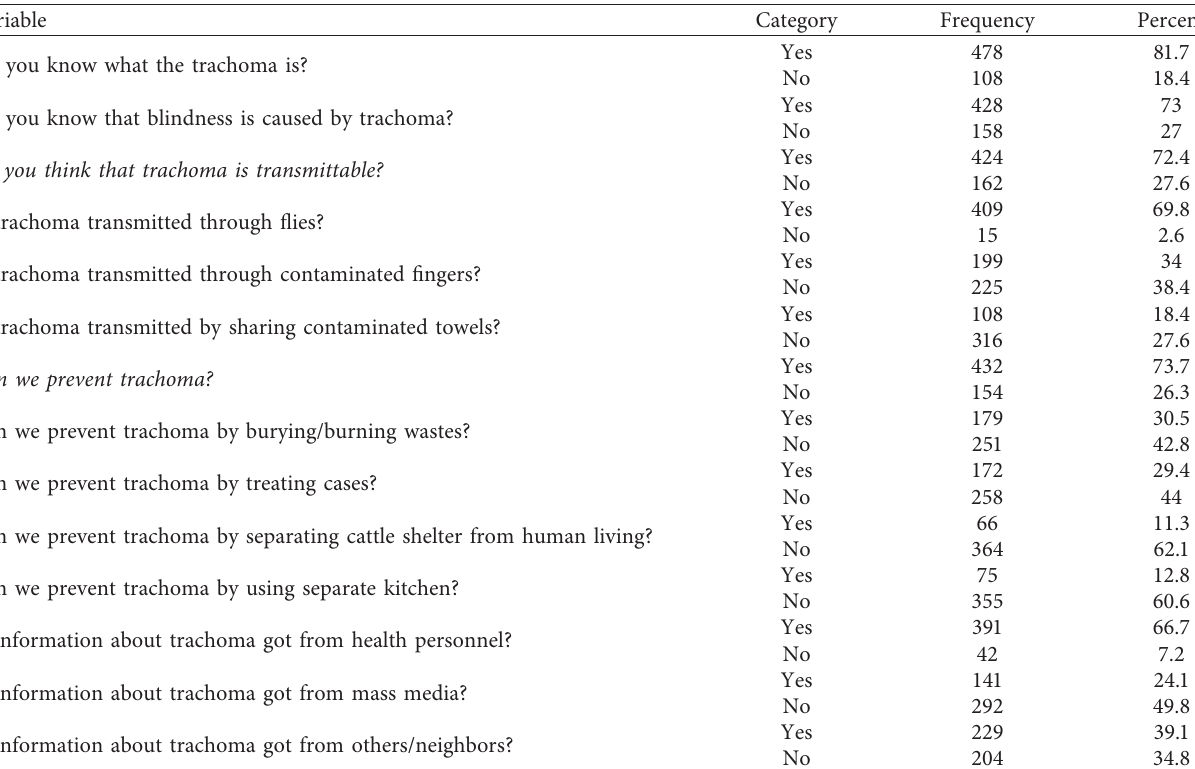
Table 2: Knowledge of respondents and source of information towards trachoma in Areka Town in Southern Ethiopia, 2018 ( N � 586).